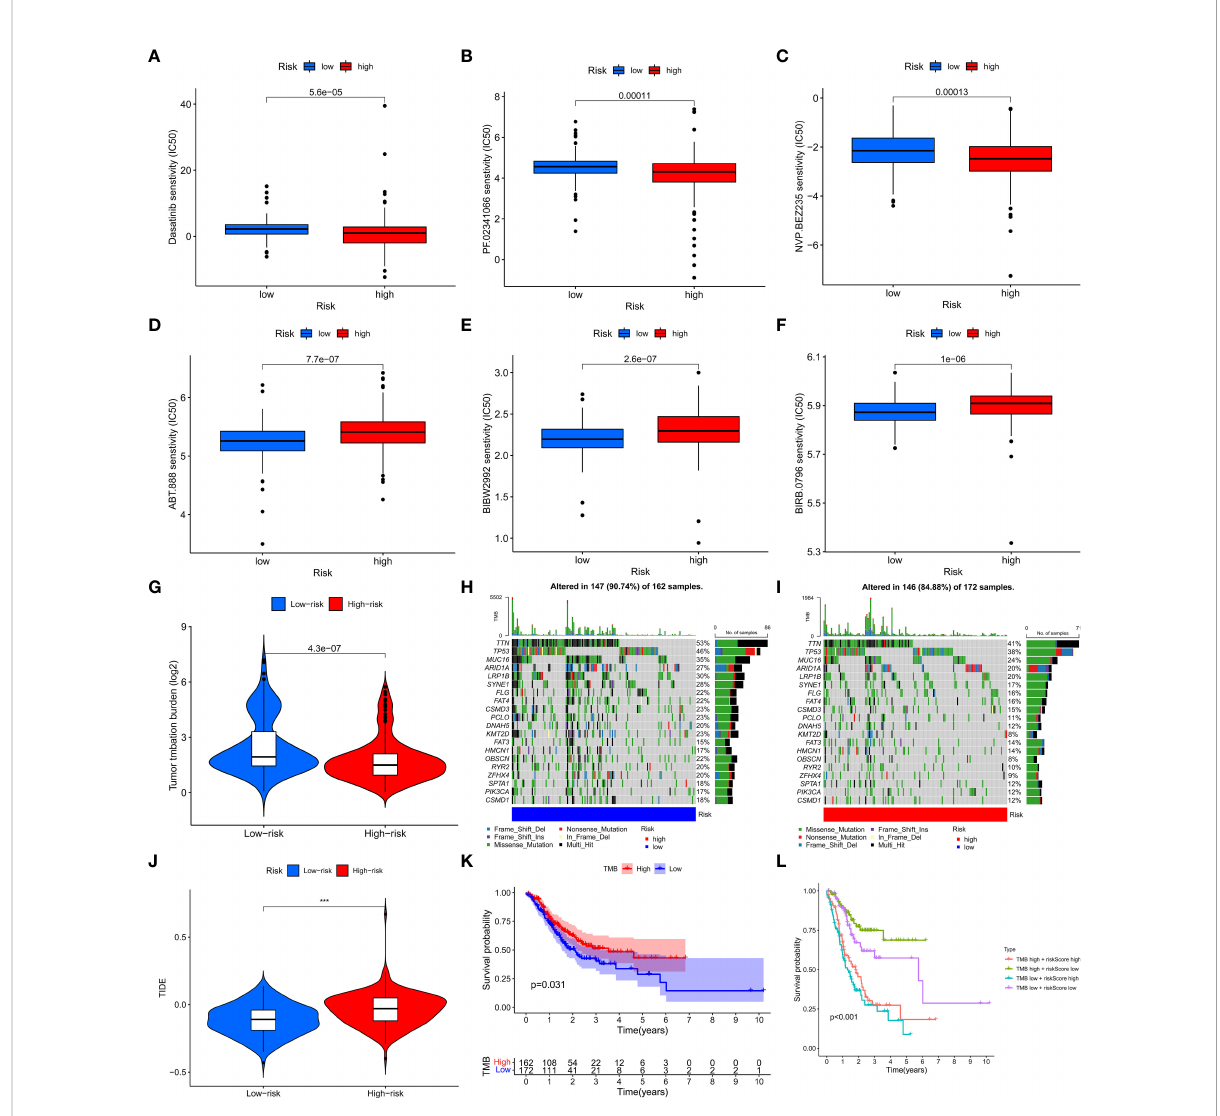
FIGURE 7 The relationship between the risk model and immunotherapy or TMB. (A – F) Drug sensitivity of patients with different risk patterns. (G) The relationship between risk score value and TMB level. (H, I) TMB status of the top 20 genes was visualized in two groups. (J) TIDE score of patients in two risk groups. (K) The survival outcome of the patients with different TMB levels. (L) The prognosis of patients with different tumor mutation burdens and different risk patterns was accessed. ***p <